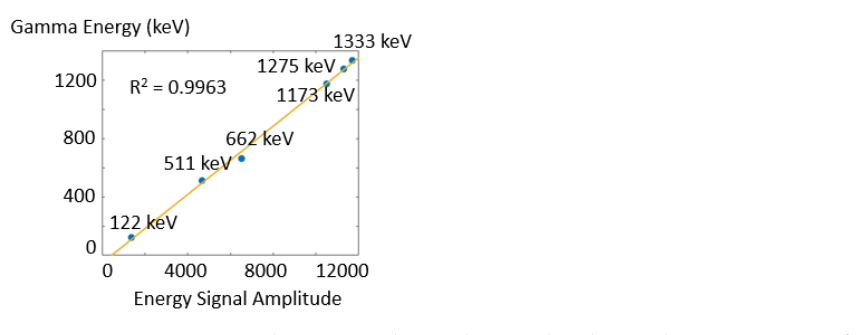
Figure 8. Energy response linearity in the single crystal and typical energy response fitting result.